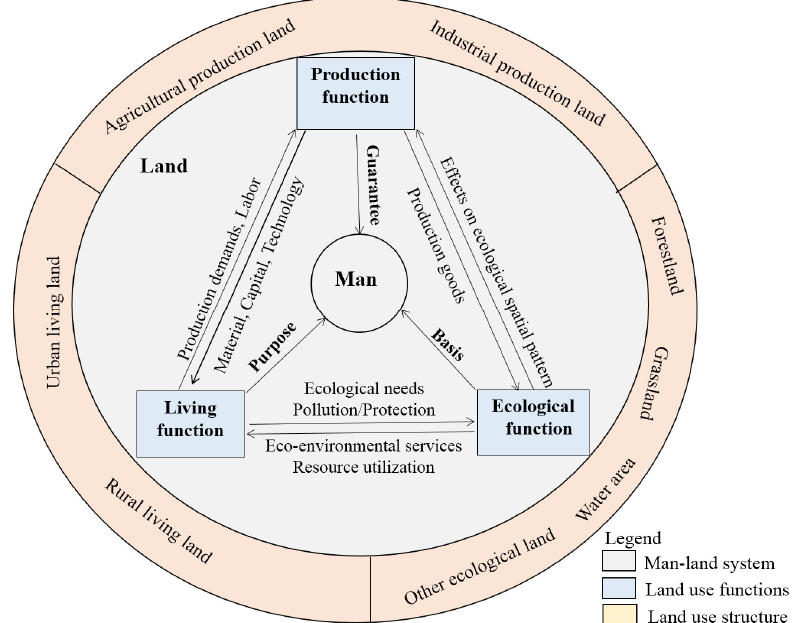
Figure 1. Relationships among production–living–ecological functions in the land system.